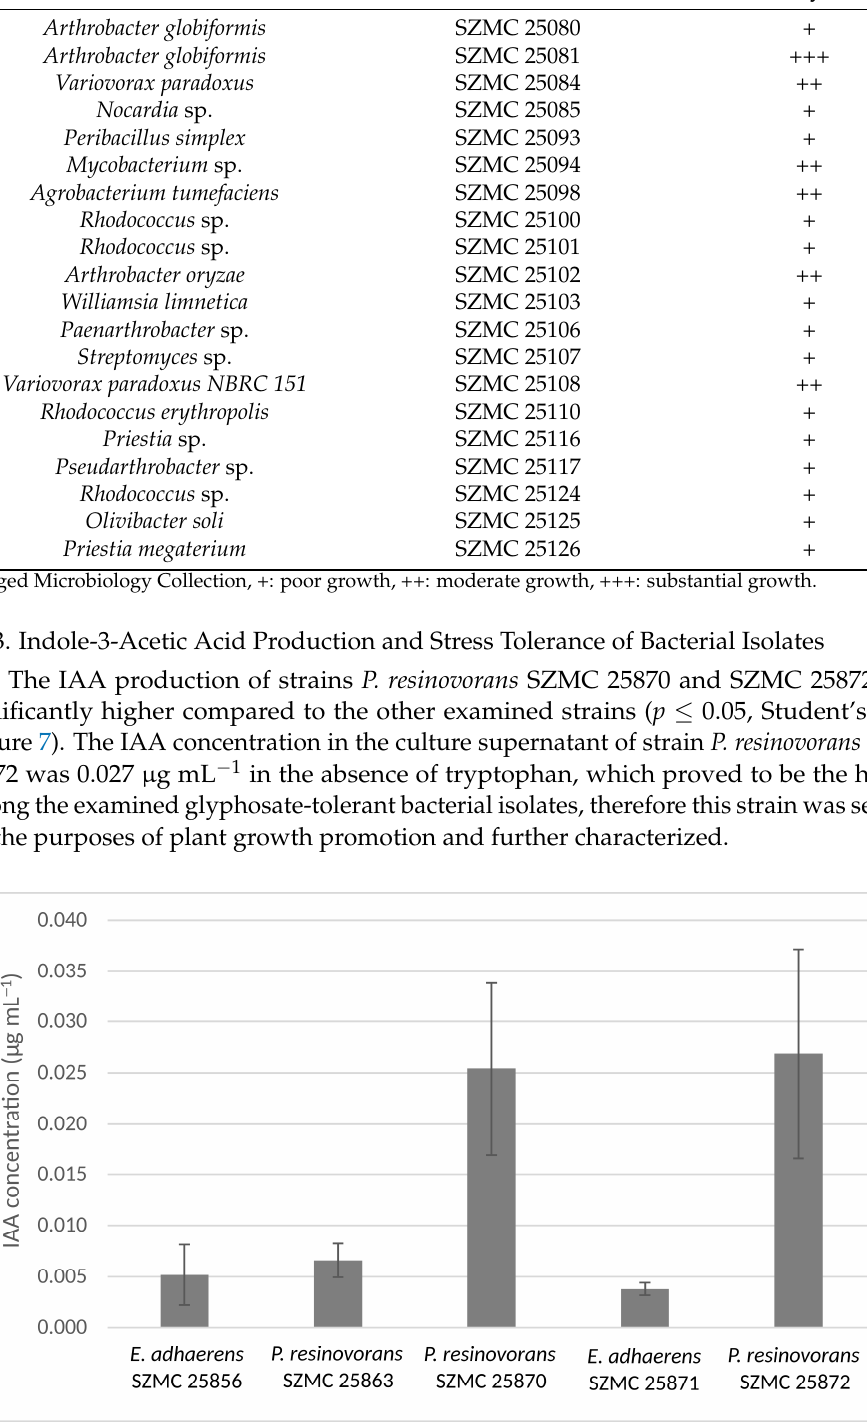
Table 3. Growth of different bacterial isolates on nitrogen free medium.